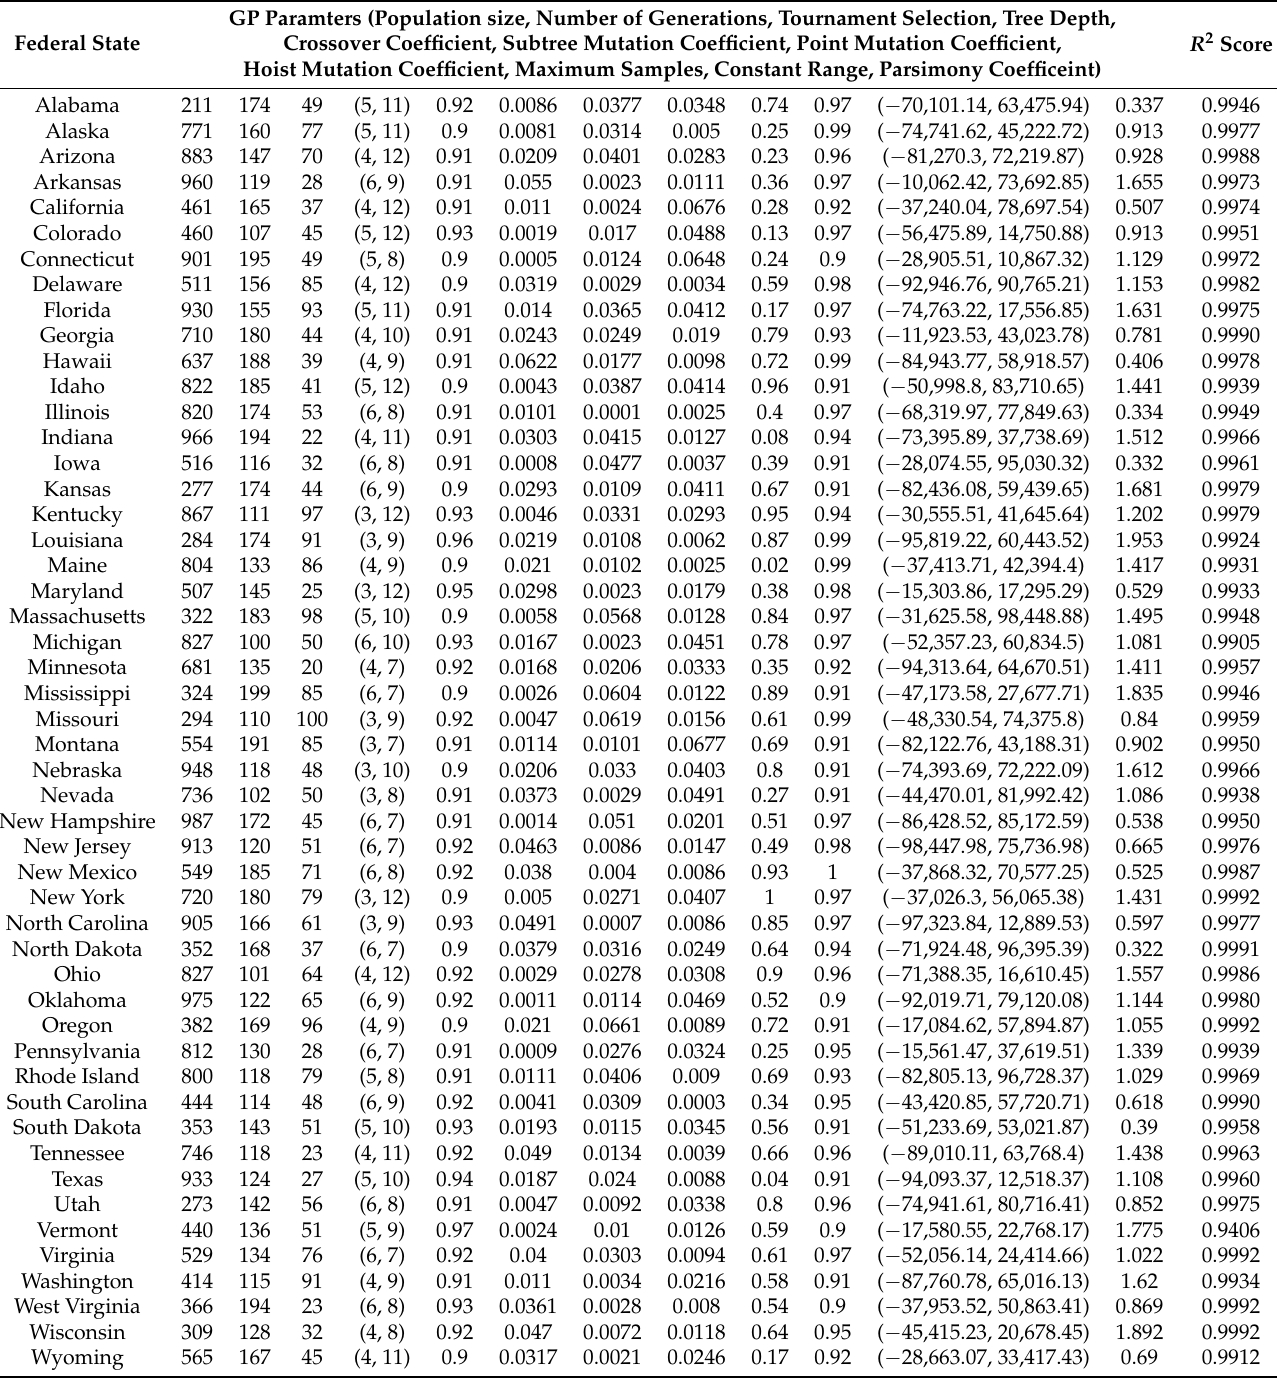
Table A1. GP parameters used to obtain symbolic expressions of confirmed patients for each state with achieved R 2